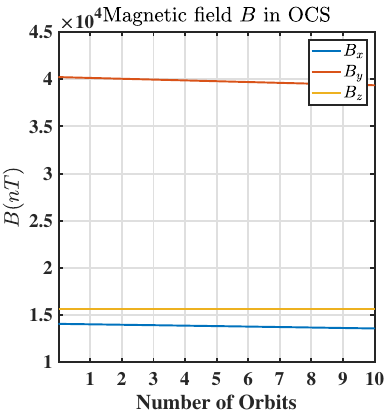
Figure 2. The magnetic field considered in the simulation studies is almost time-invariant. B x , B y and B z are the components of the dipole model in OCS (11) in the case when the satellite is following an circular equatorial orbit (see Equation (H-30) in